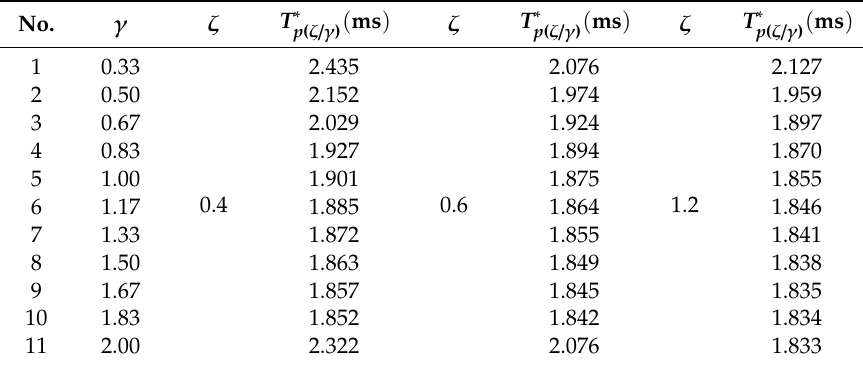
Table 5. Equation (7) calculation results.